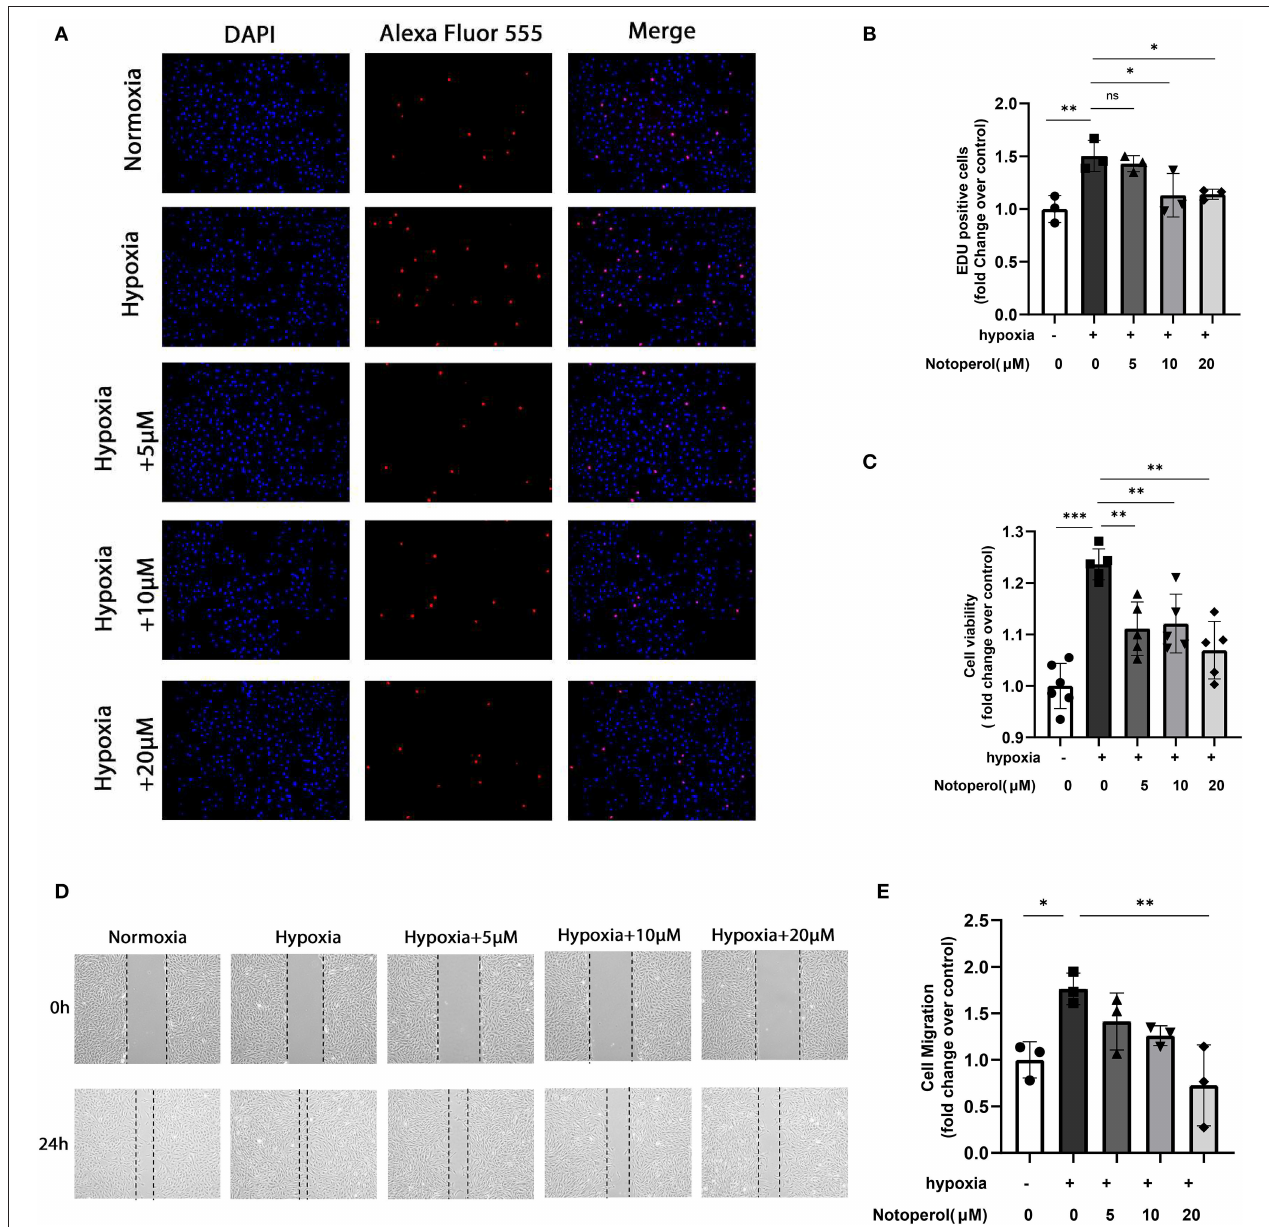
FIGURE 6 | Notopterol inhibits the proliferation and migration of human pulmonary artery smooth muscle cells in response to hypoxia in vitro . (A) Representative images of the EdU assay of HPASMCs in vitro (100 × ); (B) Quantification of the EdU assay of HPASMCs; (C) CCK-8 assay of HPASMCs; (D) Representative images of the wound healing assay of HPASMCs in vitro ; (E) Quantification of the wound healing assay of HPASMCs; ( n = 3, biological replicates; three wells each time for the EdU assay, six wells each time for the CCK-8 assay, three wells each time for the wound healing assay). * p < 0.05, ** p < 0.01, *** p < 0.001.